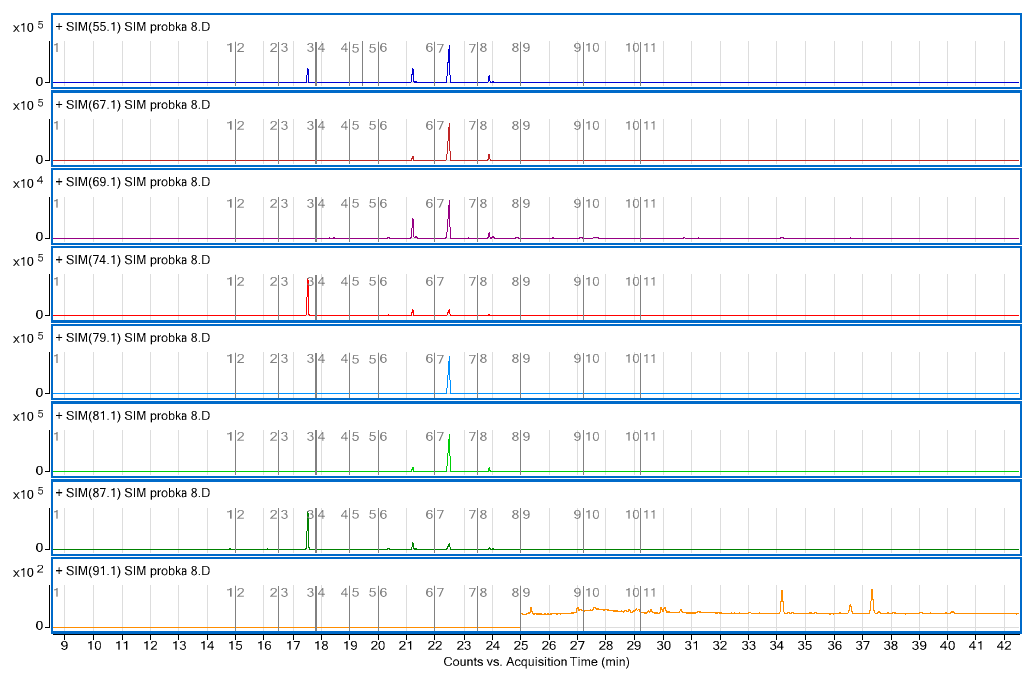
Figure 1. Chromatogram (SIM/GCMS mode) for herbal sample with the highest concentration of